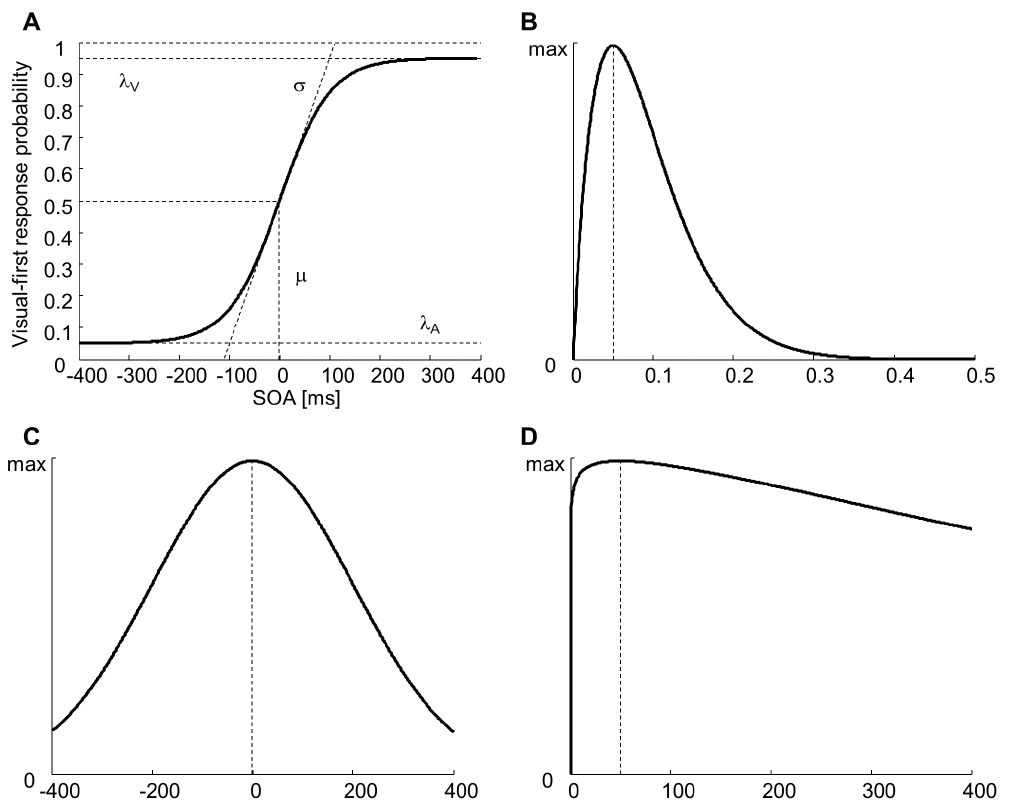
Figure 1. Parameters of the psychometric function and priors for the Bayesian analysis. A. The parameters that define the logistic function are illustrated: l A , lapse rate when the auditory stimulus precedes the visual stimulus by a long interval (large negative values of the stimulus onset asynchrony, SOA); l V , lapse rate when the visual stimulus precedes the auditory one (large positive values of the SOA); m , location parameter; s , shape parameter. In order to illustrate how the prior distributions selected for each parameter (illustrated in the following panels) affect the shape of the logistic function, the numerical values of the parameters were set to the maximum of their prior distribution. B. The beta distribution used as a prior for the lapse rates l A and l V . The maximum prior probability corresponds to l =0.05. C. The normal distribution used as a prior for the location parameter m . The maximum prior probability corresponds to m =0. D. The gamma distribution used as a prior for the shape parameter s . The maximum prior probability corresponds to s =50.